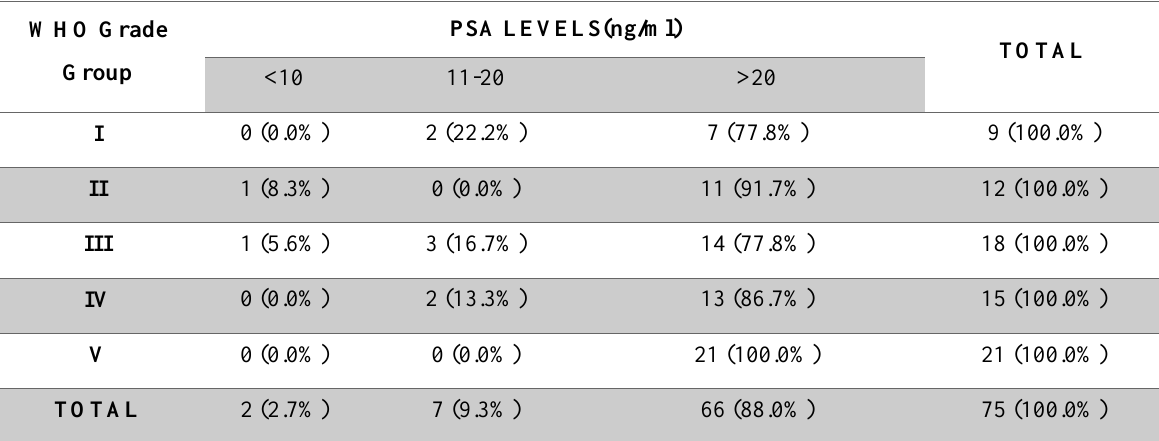
Table 6. Correlation between WHO Grade Group and serum PSA